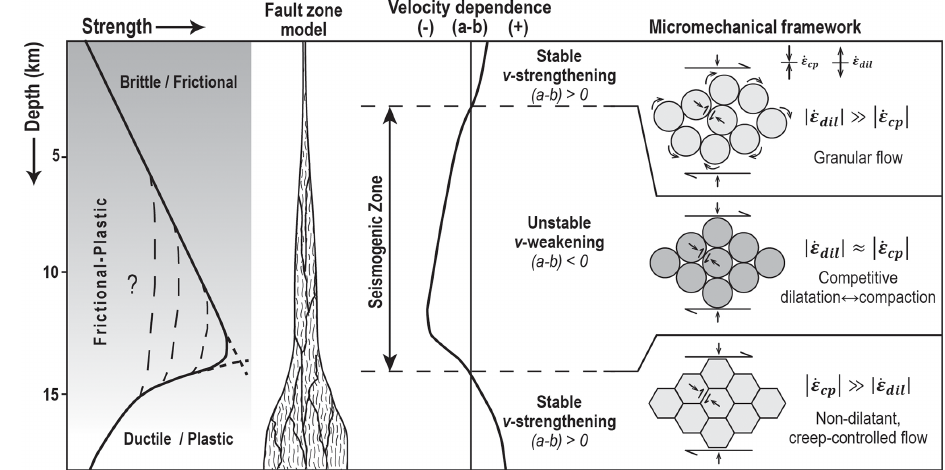
Figure 1. Conceptual model for an upper-crustal fault zone, highlighting the frictional-to-viscous transition and the seismogenic zone, which is characterized by v -weakening friction (i.e. ( a − b )<0); after Sibson (1982, 1983) and Scholz (1988, 2019). On the far right we summarize implications from the CNS model for shear of gouge-filled faults involving competition between creep-controlled compaction and dilatation by granular flow (occurring at rates of ˙ ε cp and ˙ ε gr , respectively). For model details see Bos and Spiers (2002a), Niemeijer and Spiers (2006, 2007), and Chen and Spiers